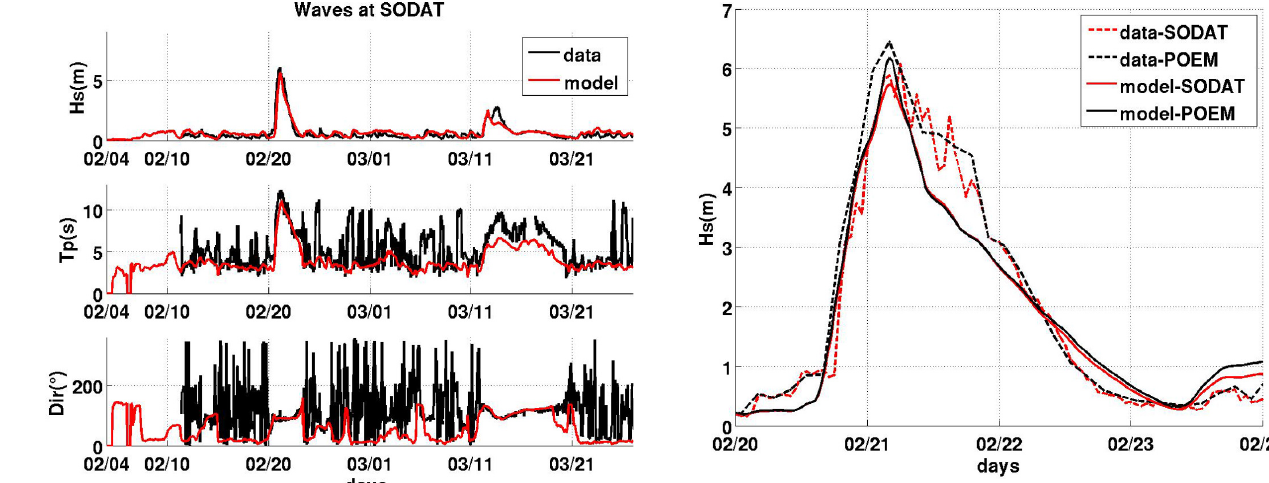
Fig. 10. Comparison of wave parameters between data and simula- tion at SODAT (11m).